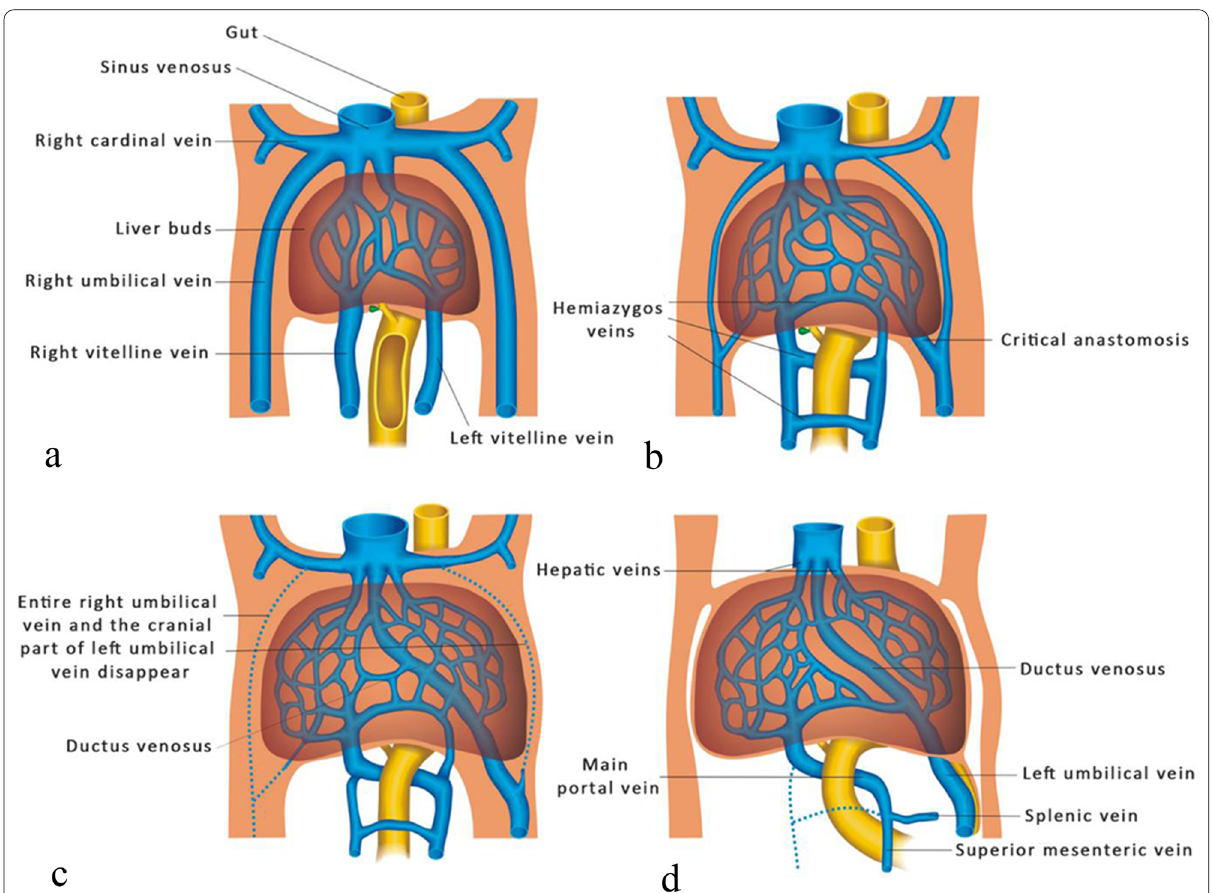
Fig. 2 Embryological development of the human umbilical–portal venous